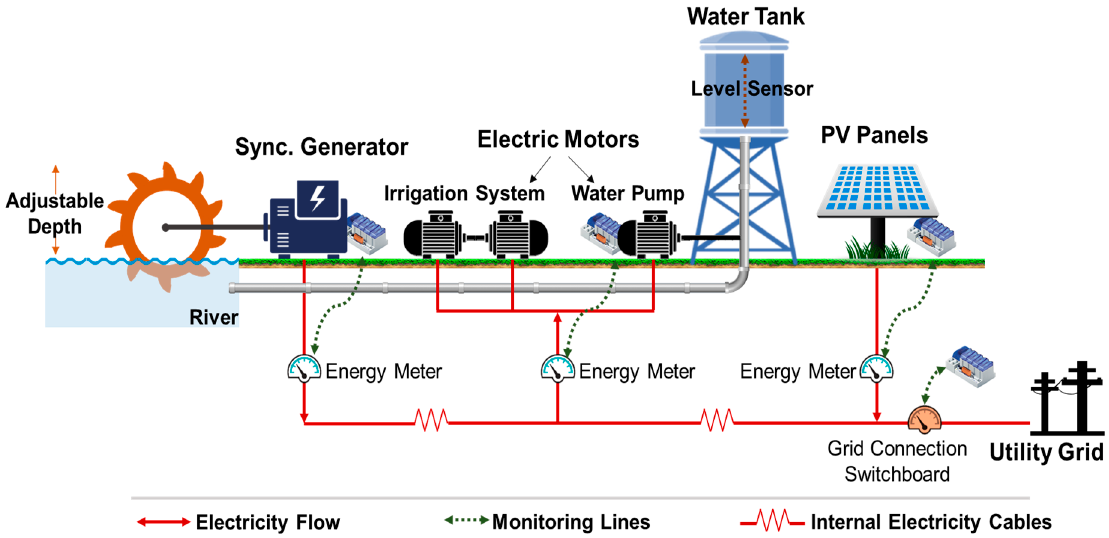
Figure 1. The architecture of the presented model for the scheduling of energy resources in agriculture.